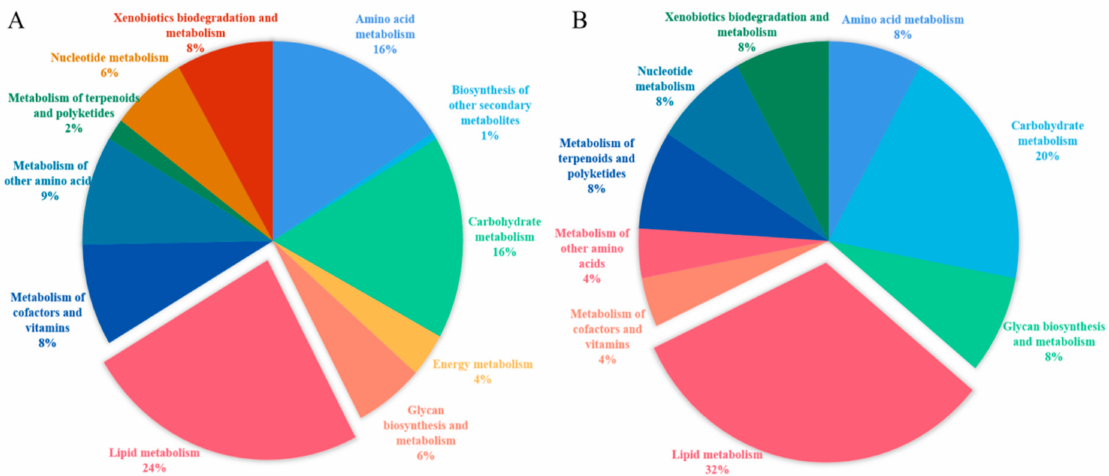
Figure 2. ( A ) The distribution of DEGs in the metabolism classification at KEGG level2; ( B ) The distribution of DEPs in the metabolism classification at KEGG